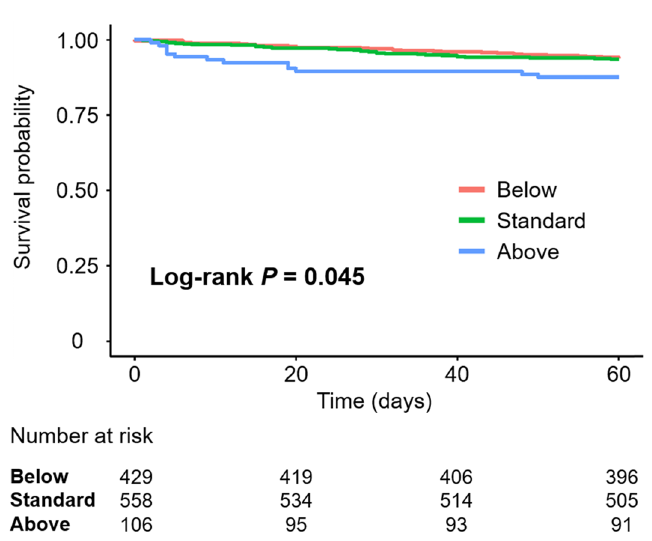
Figure 3. Kaplan–Meier curves for 60-day mortality according to the first furosemide IV dose. The Above group was significantly associated with a lower survival